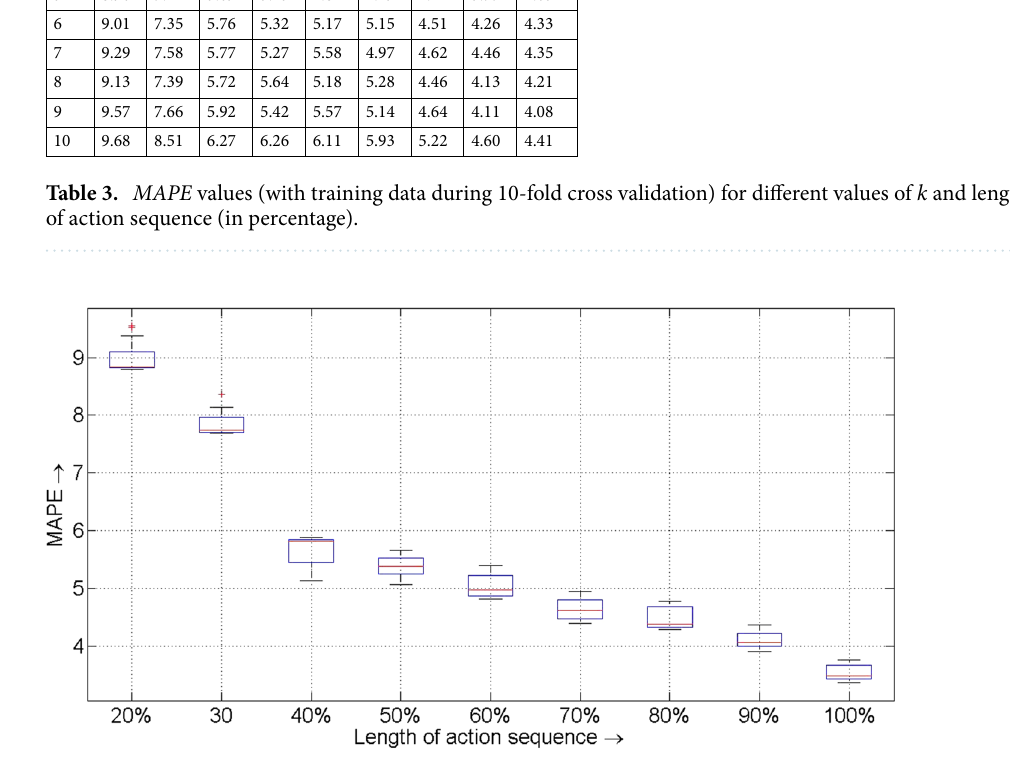
Figure 5. Boxplot of MAPE values obtained by the proposed method for different length of action sequence over 20 experimental runs (each with 10 fold cross validation of the training